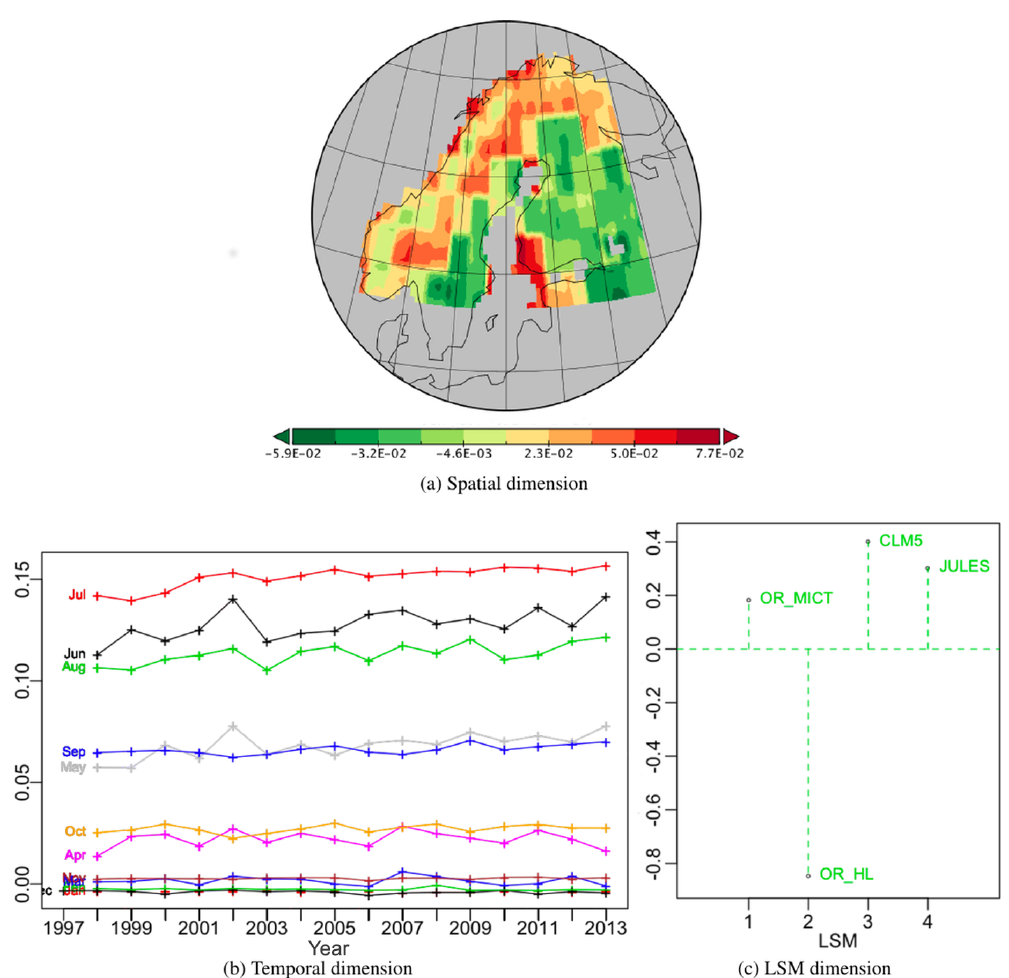
Figure 4. Plots of the components of PT -no-6 associated with PT -no-1 along its temporal dimension, which is therefore identical to Fig. 3b; it represents 3.72% of the